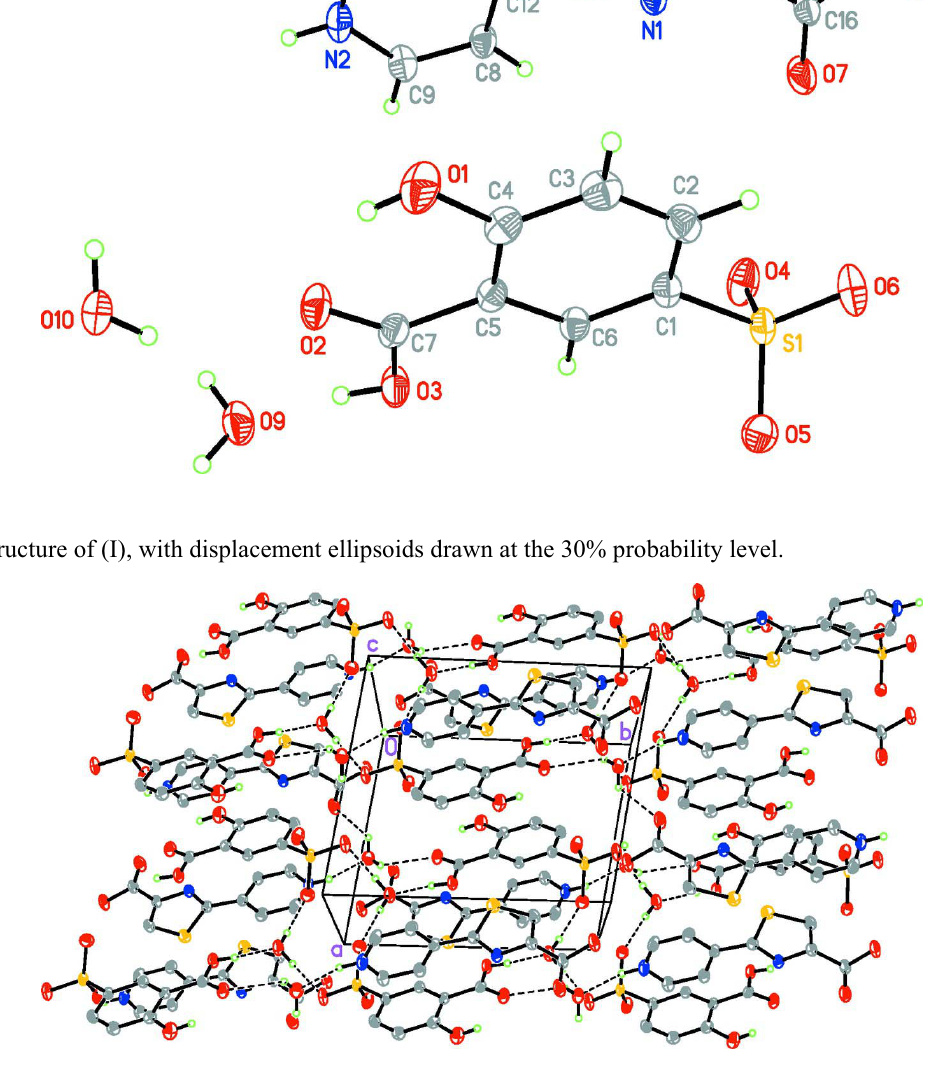
Figure 2 The crystal packing of (I), showing hydrogen bonds as dashed lines. For the sake of clarity, H atoms on C atoms have been